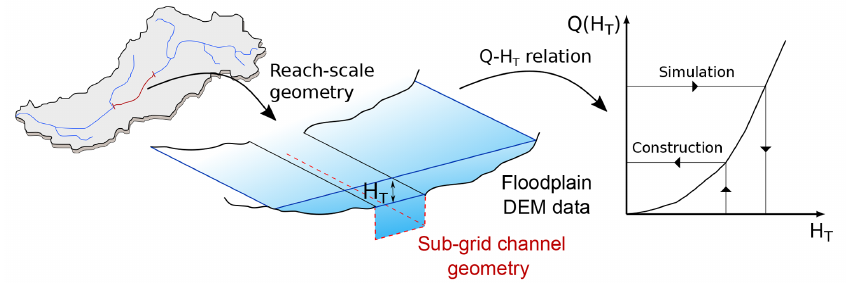
Figure 2. Representation of the model structure: the reach-scale geometry is derived from hydraulic geometry relationships and DEM data and is then used to compute a relation between the threshold height H T and the discharge Q . L is a fixed characteristic of the